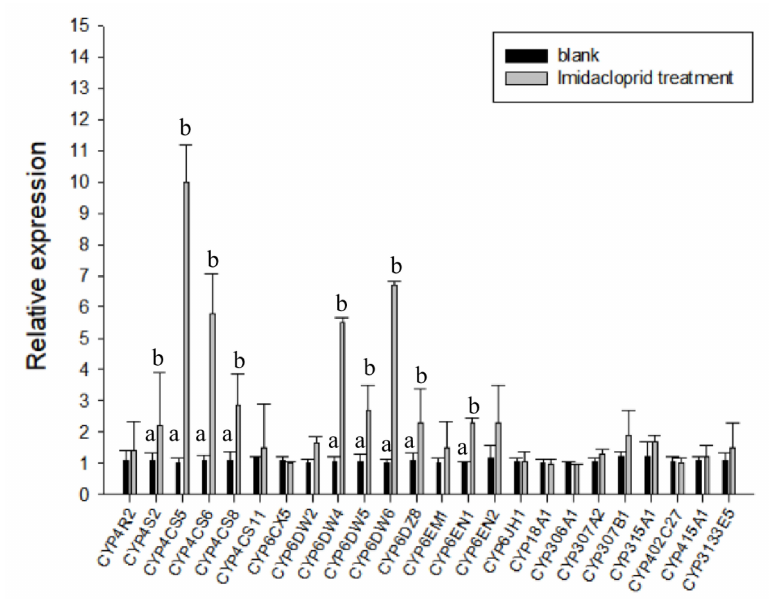
Figure 3. Expression of different genes in Bemisia tabaci MED fed imidacloprid (50 ppm). Quantitative real-time PCR (RT-qPCR) analysis of the expression profile of the BtP450 gene superfamily in B . tabaci MED. Gene names are shown on the x -axis and expression levels are shown on the y -axis. Different letters on the column indicate that the expression levels of different genes are significantly different ( p < 0.05).